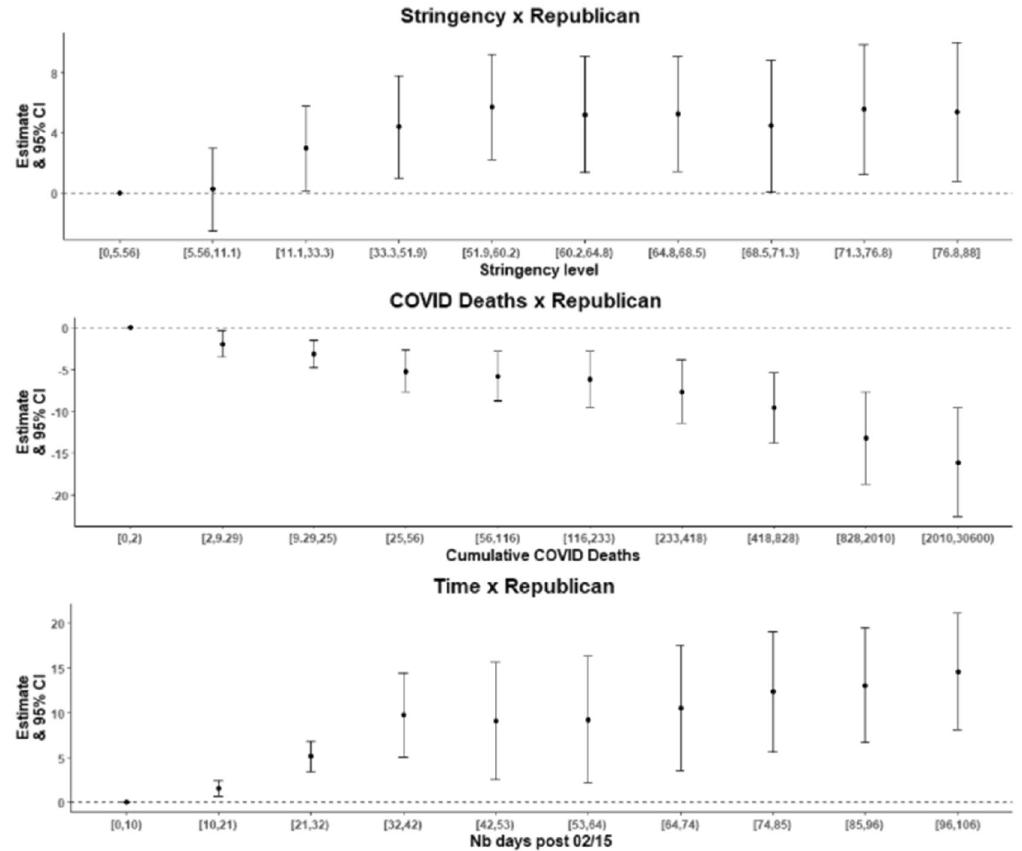
Figure 3. Event-study plots representing the effect of stringency of anti-COVID measures, number of COVID deaths and time on mobility to transit stations, modified by Republican partisanship. In each panel, the reference represents the effect of Republican partisanship on mobility at the lowest value of the variable represented on the x axis (i.e. the lowest stringency level, the lowest number of COVID-related deaths, and the lowest number of days after Feb. 15 2020—the beginning of the time series). At the reference point, the value of the corresponding parameter estimate is of 0. Other estimates have to be interpreted relative to the reference point. For instance, compared to the reference point, increasing the stringency of anti-COVID measures is associated with an increased effect of Republican partisanship on mobility to transit